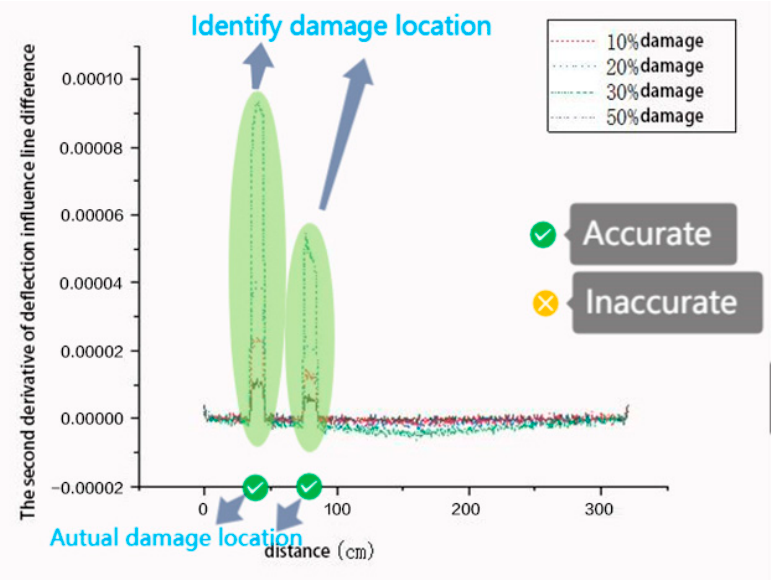
Figure 23. The 2nd derivative of deflection influences line difference at 1/4 determining point of the 1st span following work condition 2 (2-5).